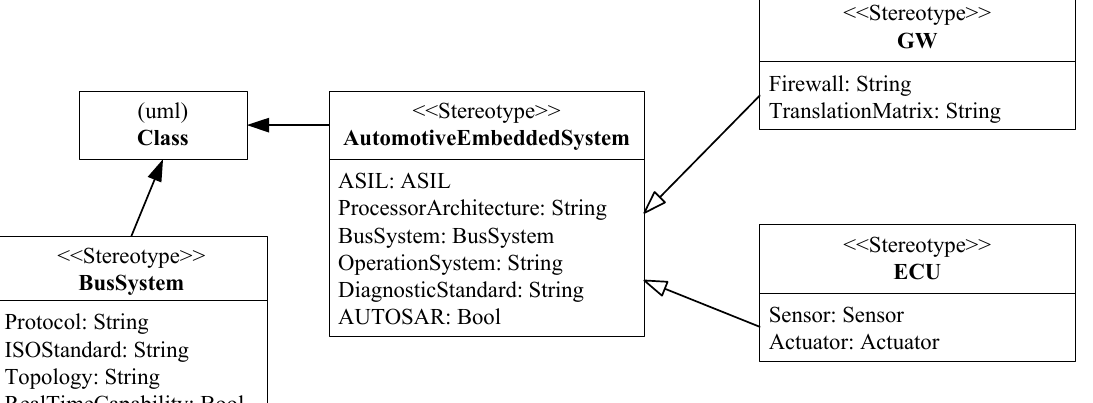
Figure 4. Basic relationships between the different systems in